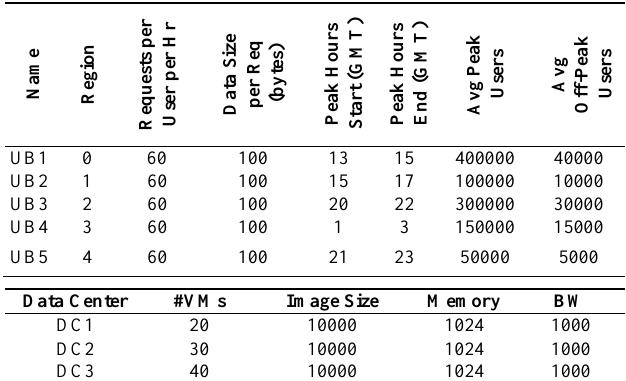
Table 1. Configuration of the user base and the data center used by CloudAnalyst [14].